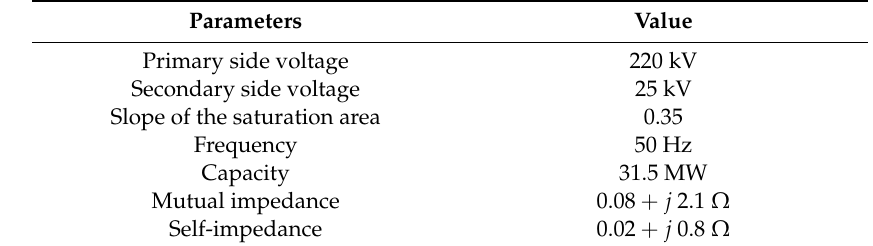
Table 3. Traction transformer parameters.